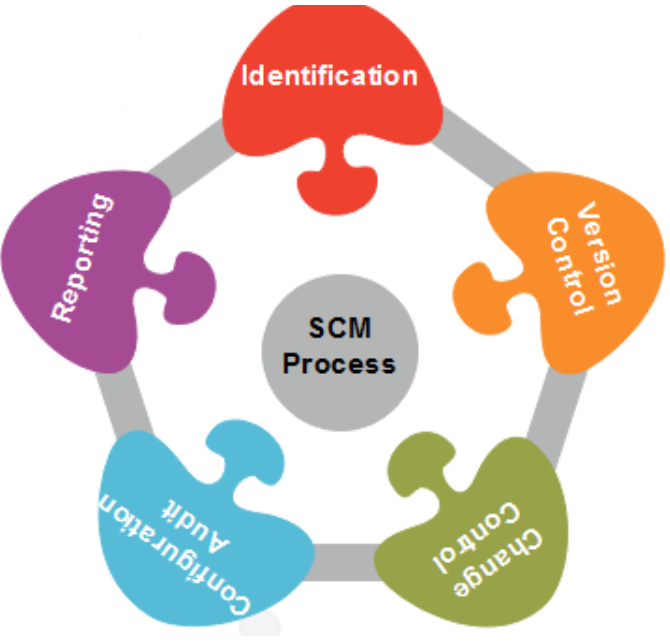
Figure 1. Software configuration management process.